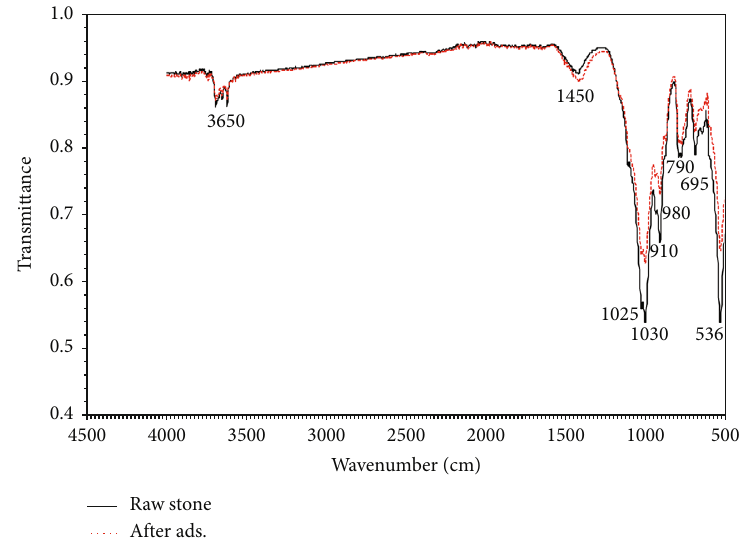
Figure 5: FTIR spectrum of Bayburt stone before and after Pb (II)